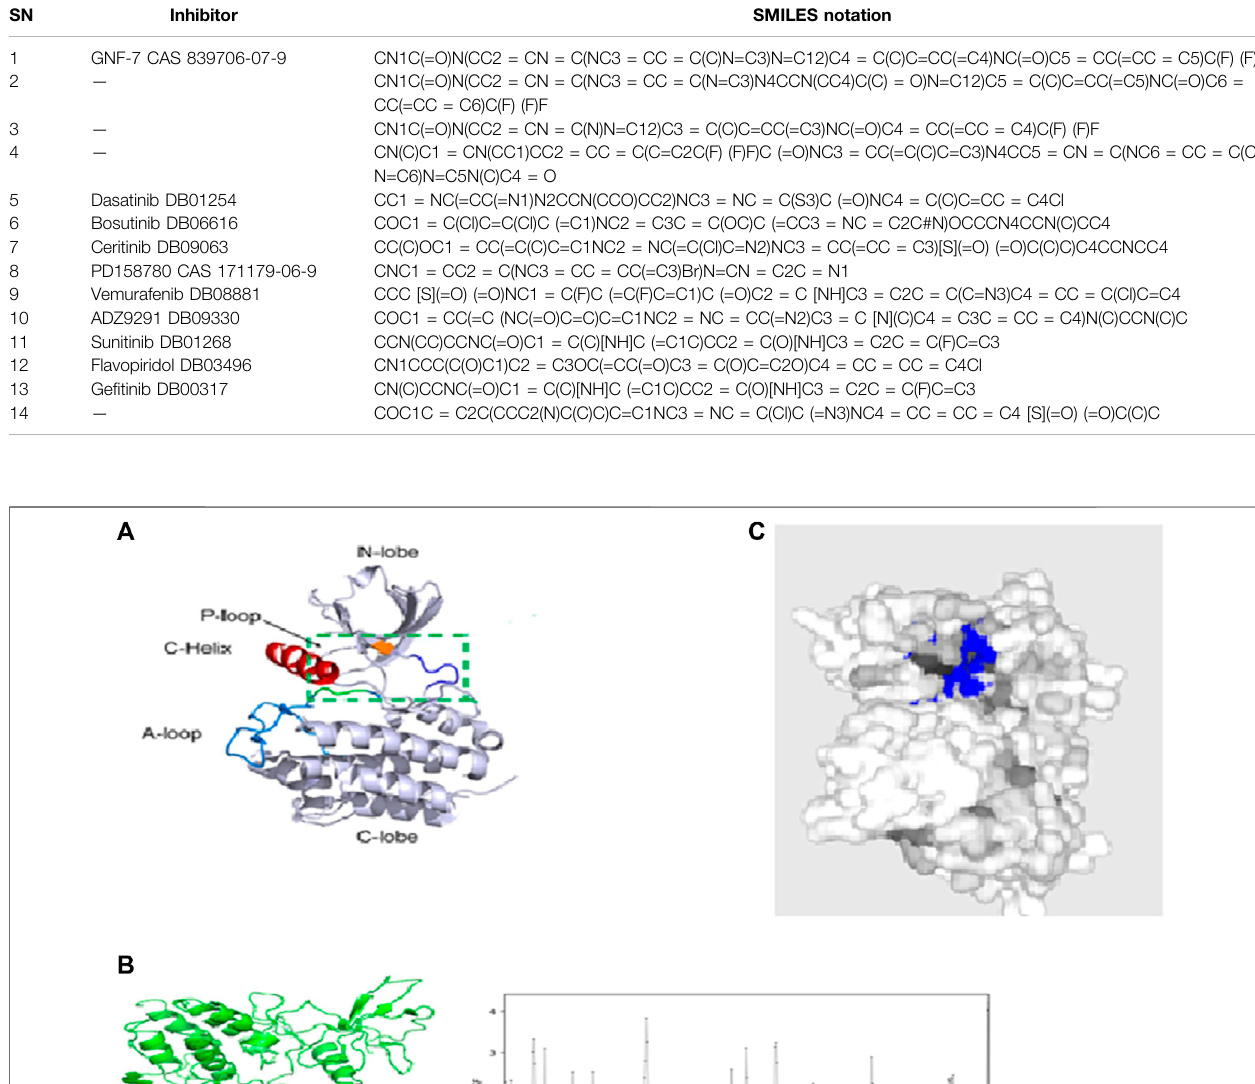
Frontiers in Chemistry |